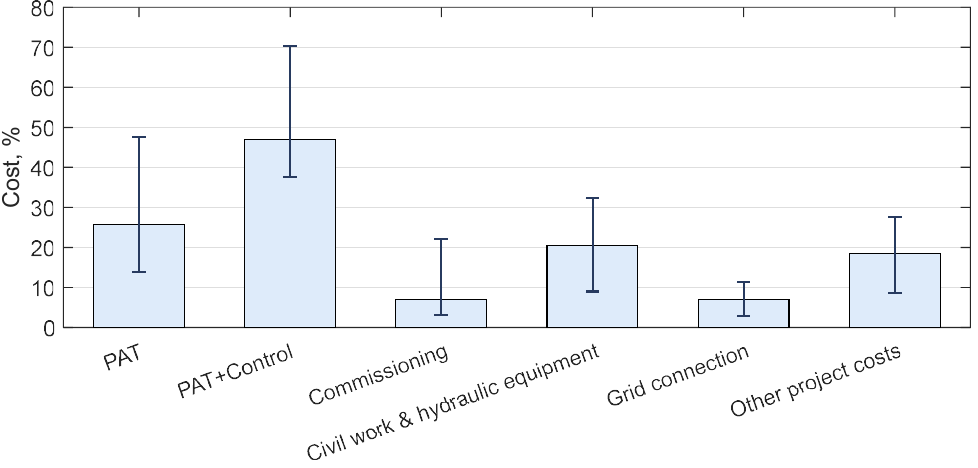
Figure 9. Costs involved in the PAT installation.